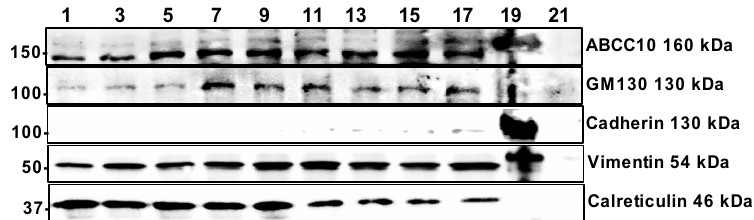
Figure 7. Localization of ABCC10 with subcellular membranes. Liver homogenates from wildtype mouse were used to separate the ER, Golgi and cell membranes using Percoll density gradient ultracentrifugation. Western blot analysis of subcellular fractions was performed using specific antibodies against ABCC10 or housekeeper protein markers of Golgi (GM1340), cell membrane (Cadherin), cytoskeleton (Vimentin), and ER (Calreticulin).